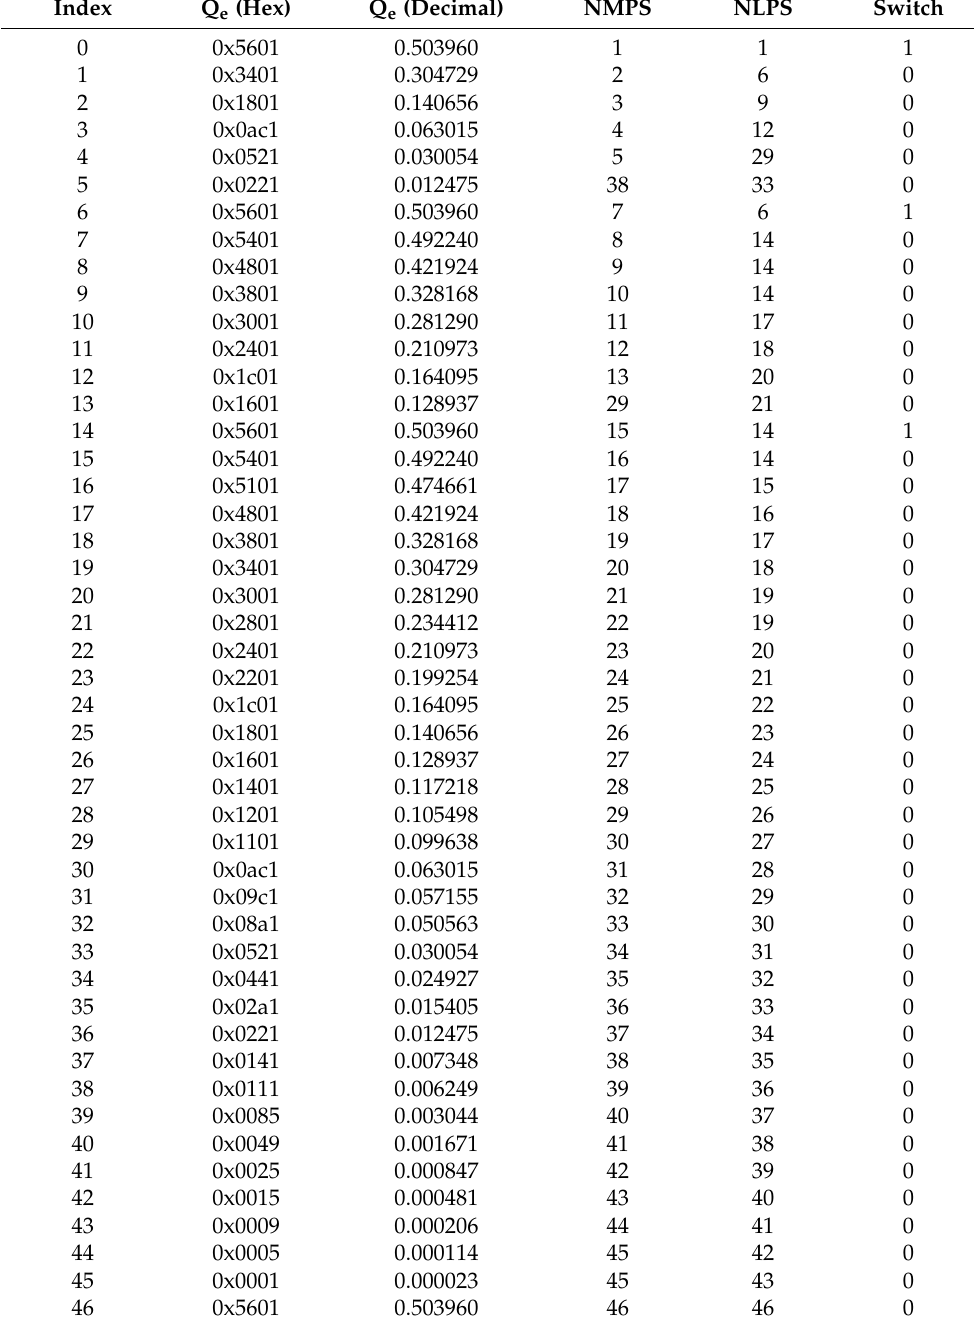
Table 1. LPS probability estimation table in MQ